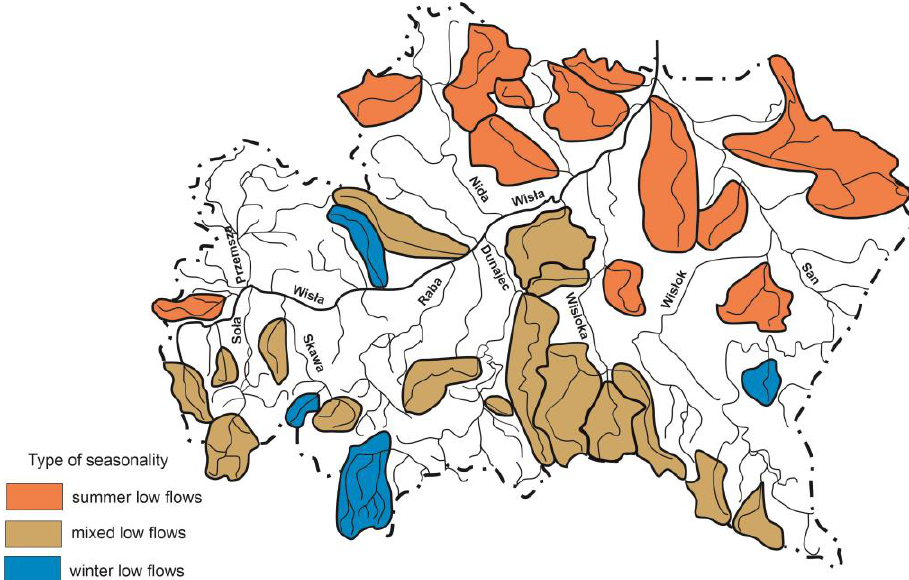
Figure 5. Localization of catchments for three type of seasonality.